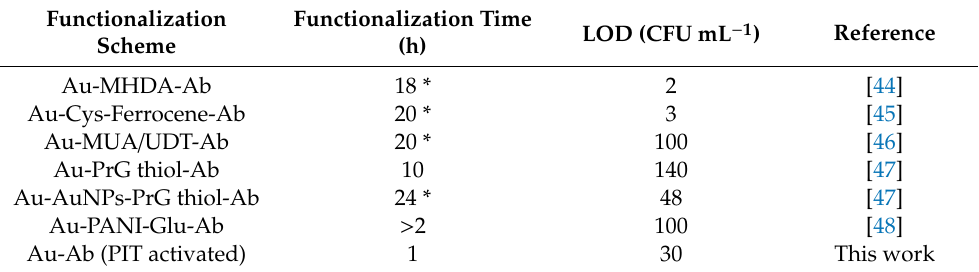
Table 1. Overview of the latest impedimetric biosensors for Escherichia coli detection. Functionalization